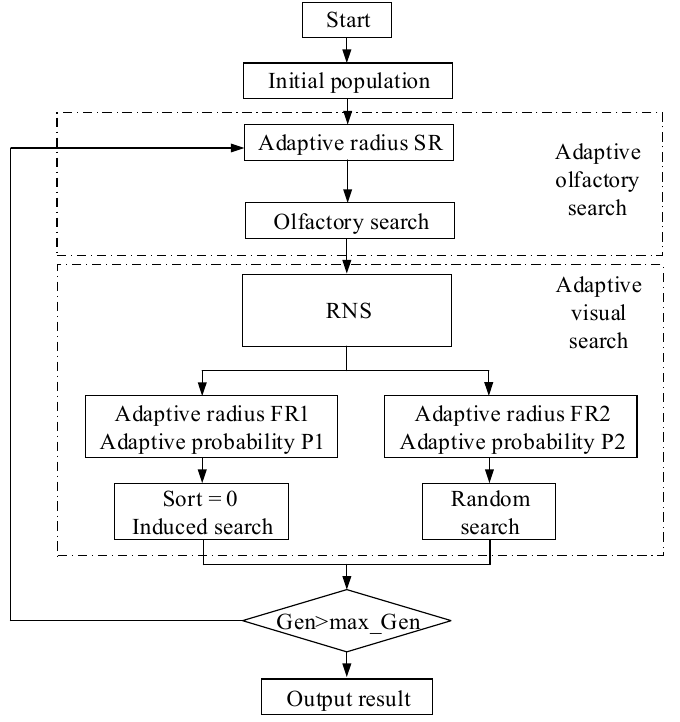
Figure 9. RNS-FOA flow char.